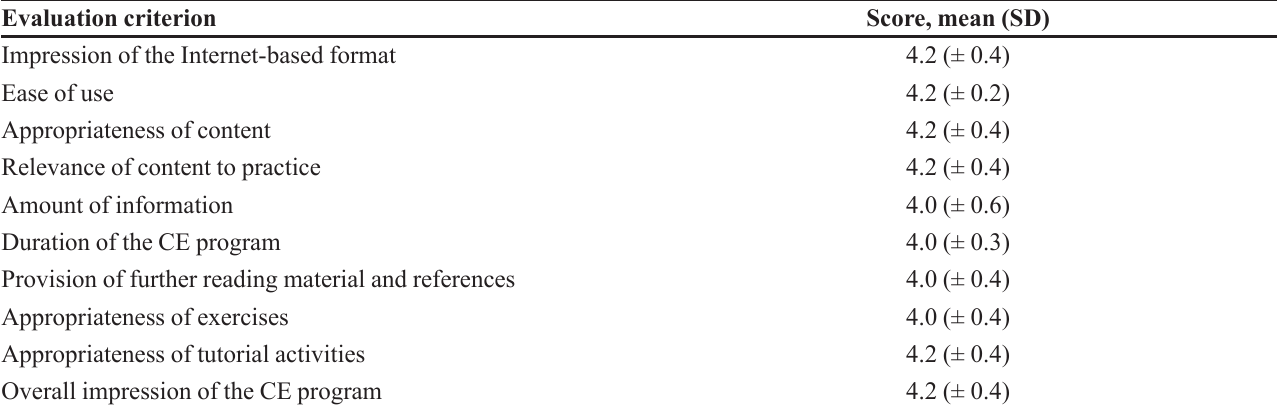
TABLE II - Scores for leaner satisfaction (Level 1) with the continuing pharmaceutical education program (intervention group; n = 33) Evaluation